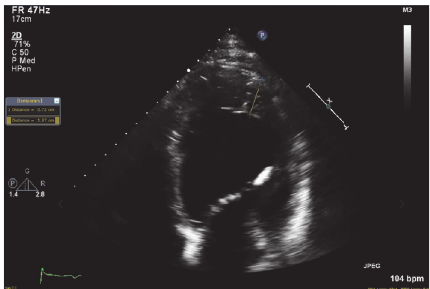
Figure 4: Apical four-chamber view of echocardiography demon- strating the end diastolic ratio of noncompacted layer 18.7 mm (yellow marking) and compacted layer 7.2 mm (blue marking) with resultant ratio of >